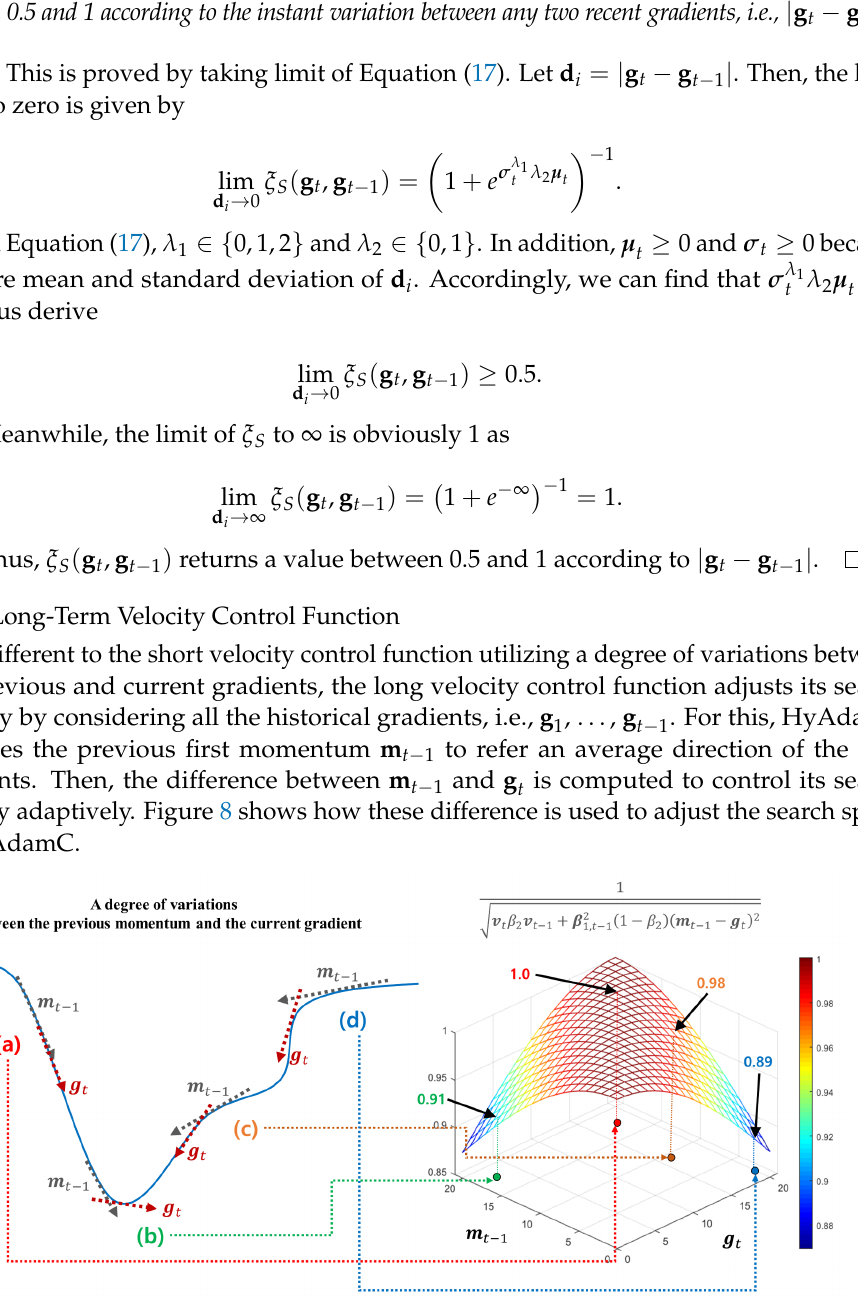
Figure 8. The principles of the long-term velocity control function. The left examples, i.e., ( a – d ) show how much the difference between m t − 1 and g t . The right graph shows a plot of the long-term velocity control function in two-dimensional space. Each arrow from the left to the right figures describes how these differences are mapped to the long-term velocity control